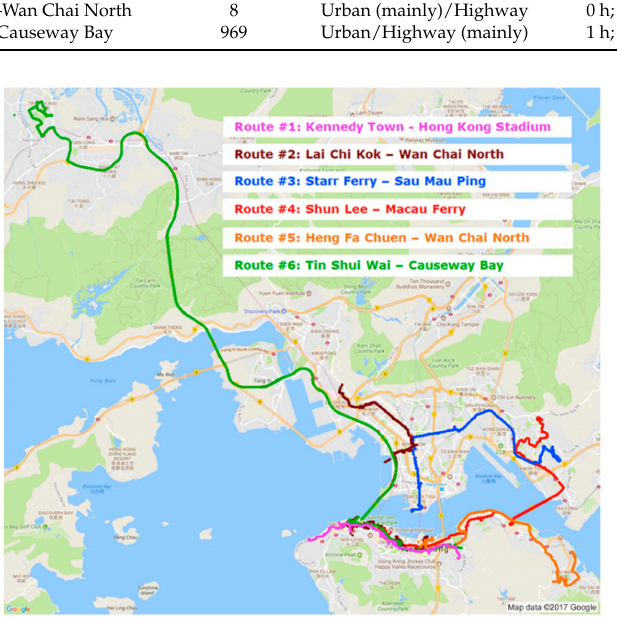
Figure 2. Schematic of the city bus routes employed in the PEMS measurement campaign, superimposed on the Hong Kong metropolitan area map. A mix of conditions ranging from urban to rural and highway roads were